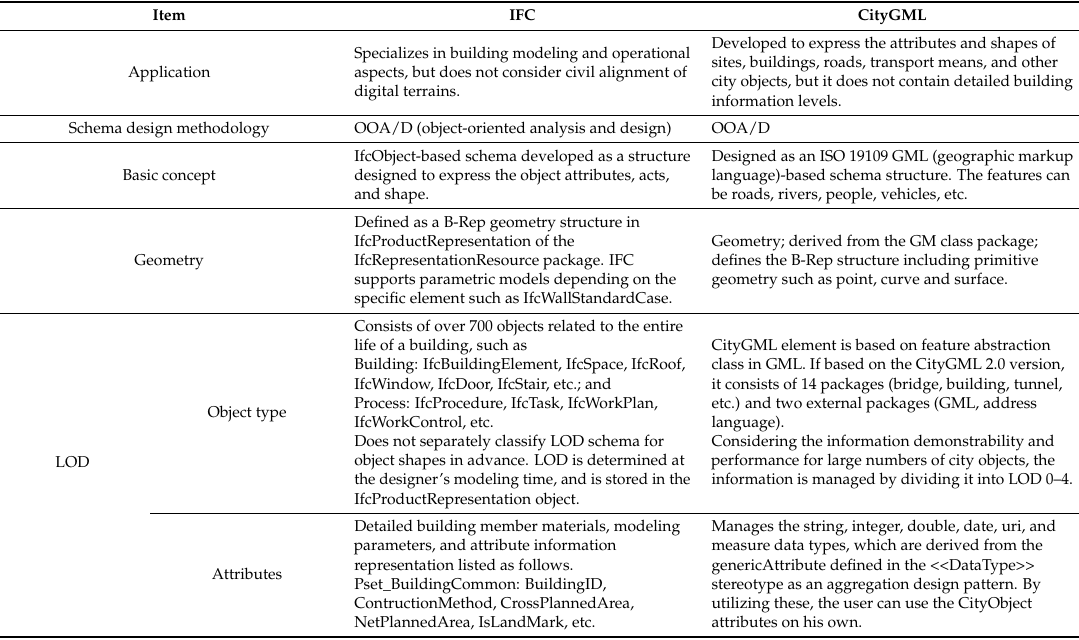
Table 2. Comparison of the standard schema characteristics between IFC and